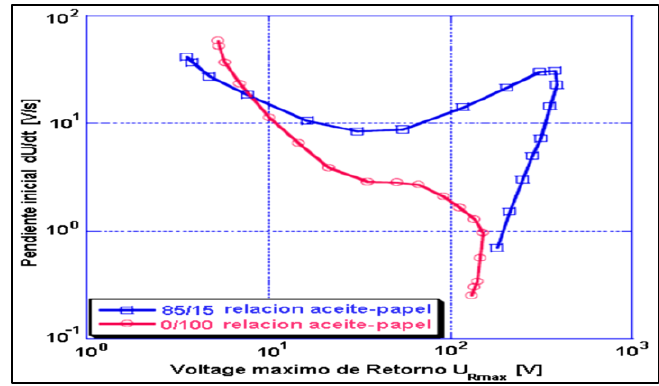
Figura 8: Representación de Guuinic.